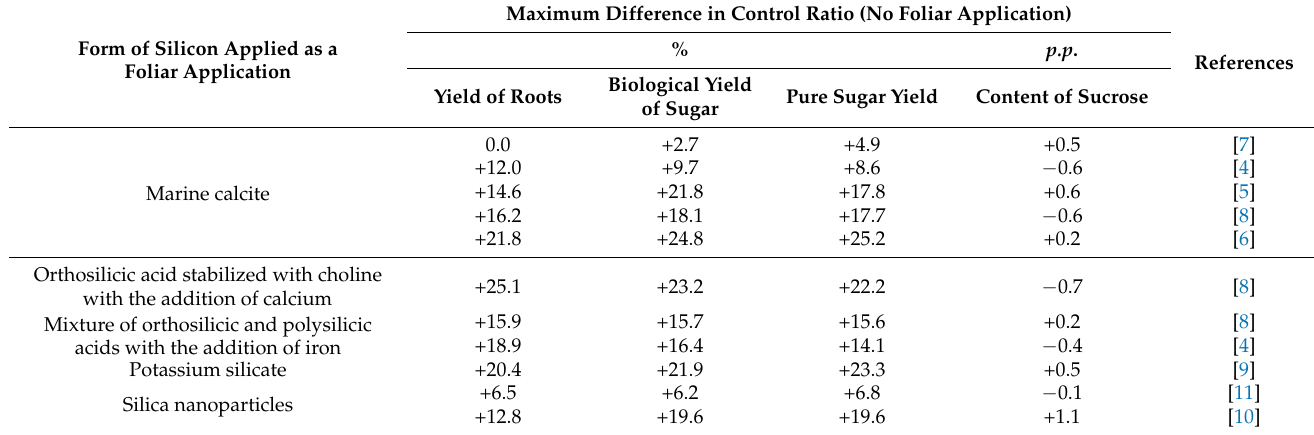
Table 6. Results of studies on foliar application of various forms of silicon in the cultivation of sugar beet. Maximum Difference in Control Ratio (No Foliar Application) Form of Silicon Applied as a References% p.p Foliar Application